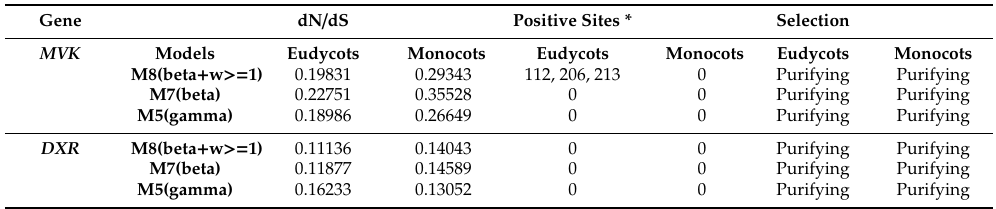
Table 2. Average non-synonymous (dN) and synonymous (dS) substitution ratios for MVK and DXR genes in eudicotyledonous and monocotyledonous plants. Gene dN / dS Positive Sites * Selection MVK Models Eudycots Monocots Eudycots Monocots Eudycots Monocots M8(beta + w >= 1) 0.19831 0.29343 112, 206, 213 0 Purifying Purifying M7(beta) 0.22751 0.35528 0 Purifying Purifying M5(gamma) 0 Purifying Purifying DXR M8(beta + w >= 1) 0.11136 0.14043 0 0 Purifying Purifying M7(beta) 0.11877 0.14589 0 0 Purifying Purifying M5(gamma) 0.16233 0.13052 0 0 Purifying